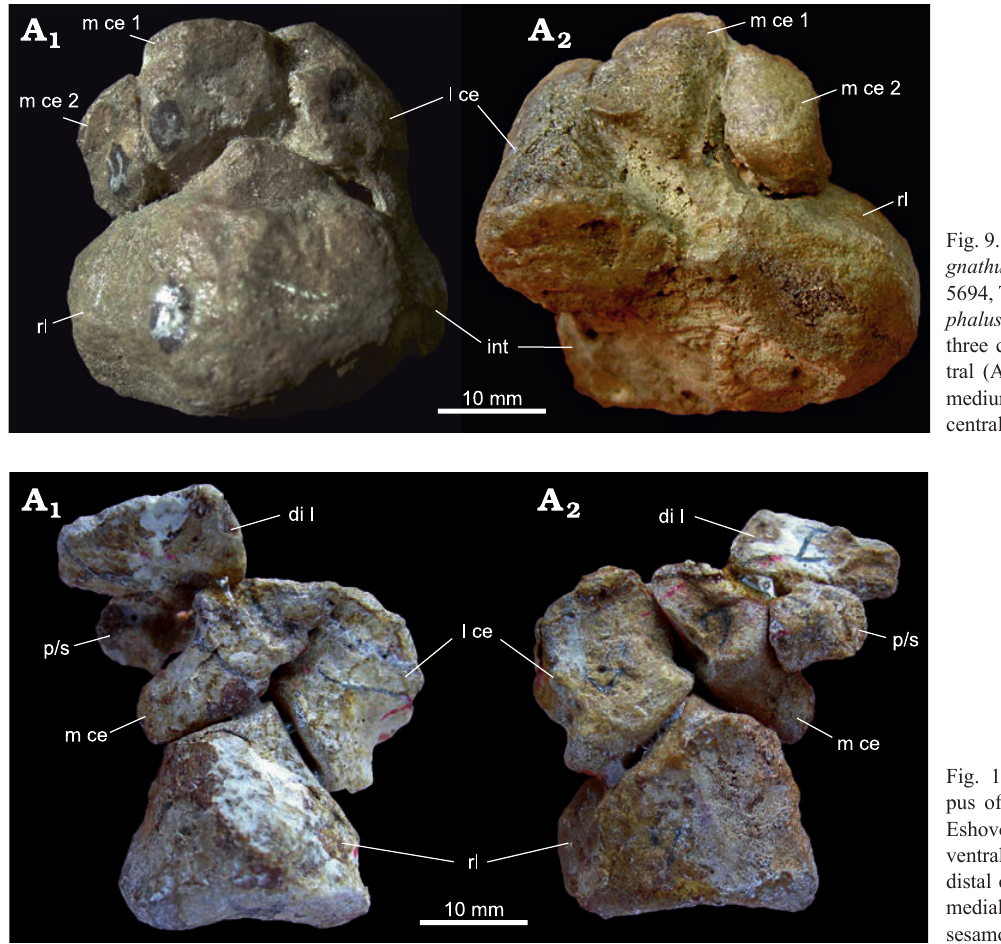
Fig. 10. Prepollex/sesamoid on the car- pus of the biarmosuchian PIN 1758/320, Eshovo, Russia, Roadian. Dorsal (A 1 ) and ventral (A 2 ) views. Abbreviations: di I, distal carpal I; l ce, lateral centrale; m ce, medial centrale; rl, radiale; p/s, prepol lex/